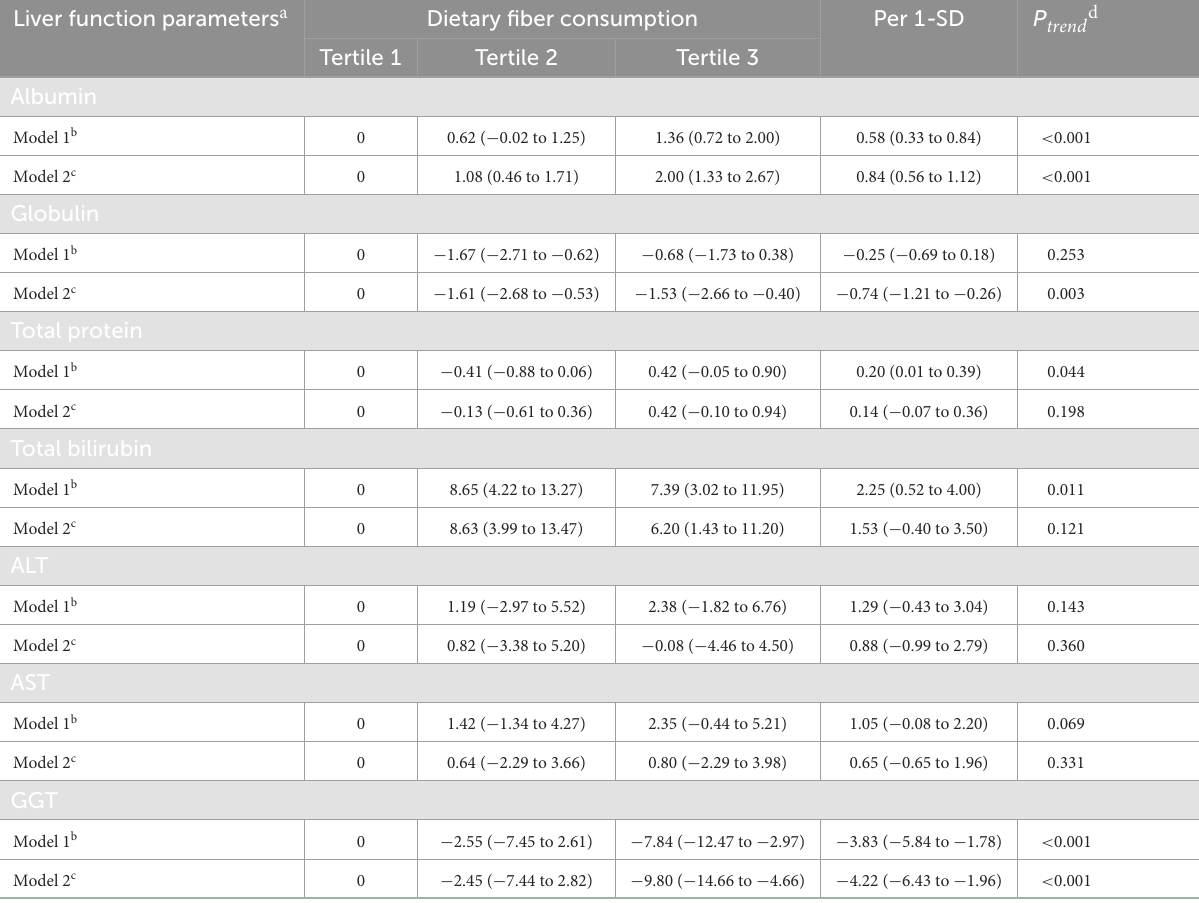
TABLE 3 The associations of dietary fiber consumption with liver function parameters. Liver function parameters